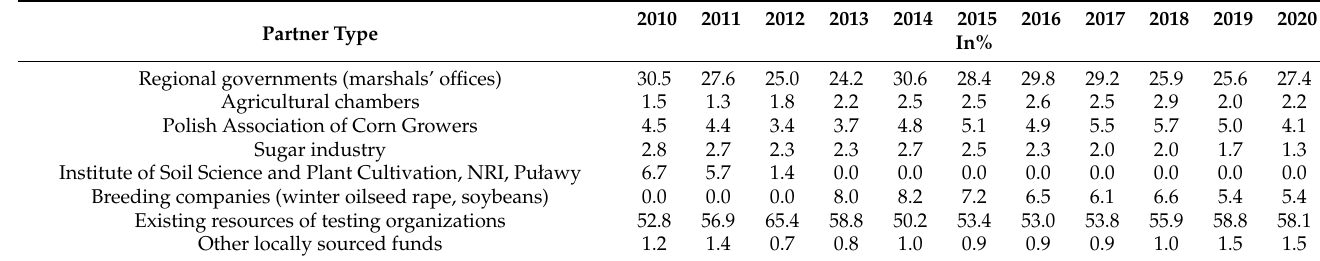
Table 2. Partners who have contributed financially to PRVT testing,